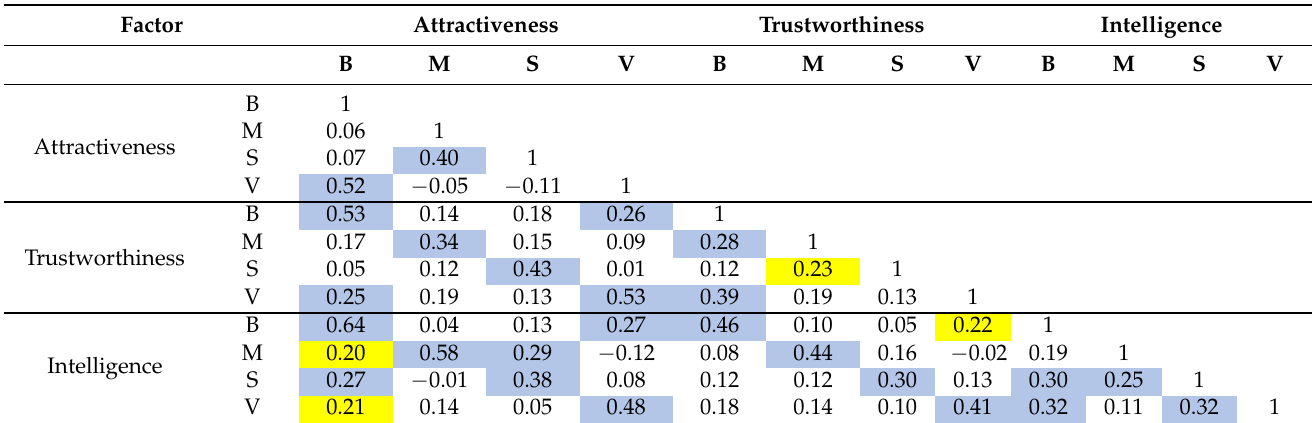
Table A2. Pearson correlations for Experiment